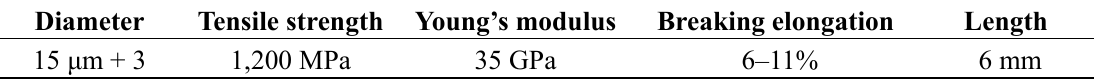
Table 2. Fiber characteristics.